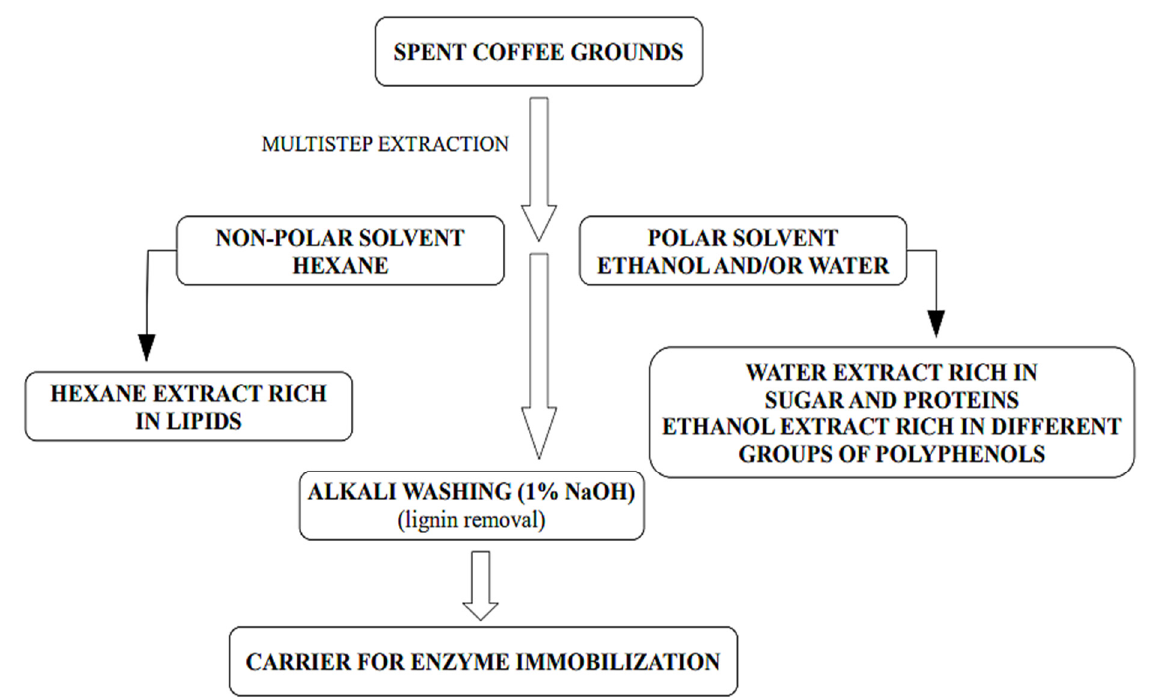
Figure 7. Schematic representation of the transformation of spent coffee grounds and brown onion- skins into high-value biological compounds and lignocellulosic material. Own compilation based on literature data [97].